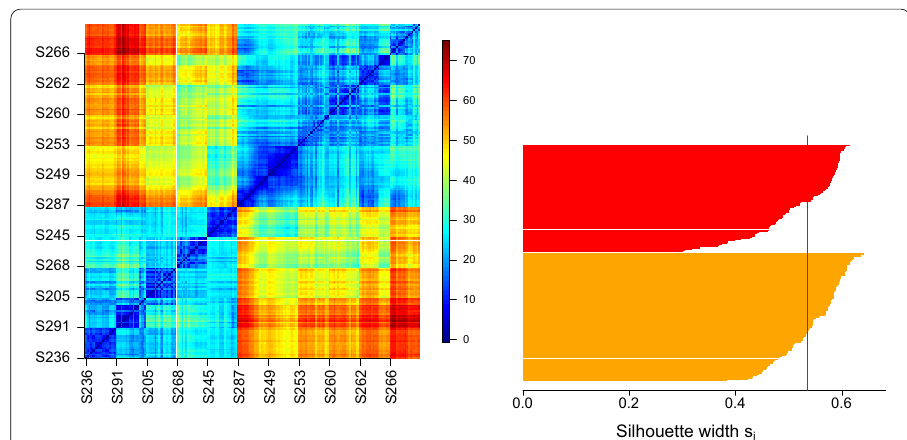
Fig. 5 Left: Heatmap of DGCD-129 distance matrix for the reduced networks. Rows and columns are primarily ordered by service class, and then by year from 1995 to 2012. The colorbar shows that the colder the colour, the smaller the distance between graphs, i.e. the higher their similarity. Right: Silhouette plot for the two-group clustering dictated by the heatmap. The vertical red line denotes the average silhouette value